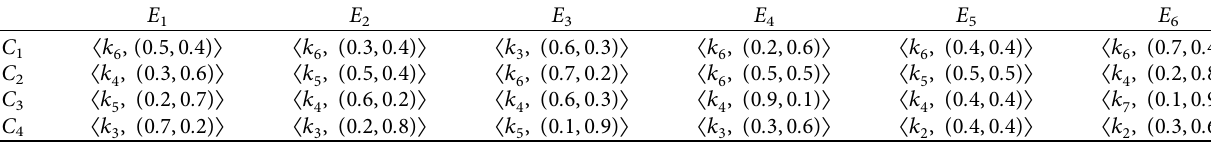
Table 3: Intuitionistic linguistic matrix-expert 1.